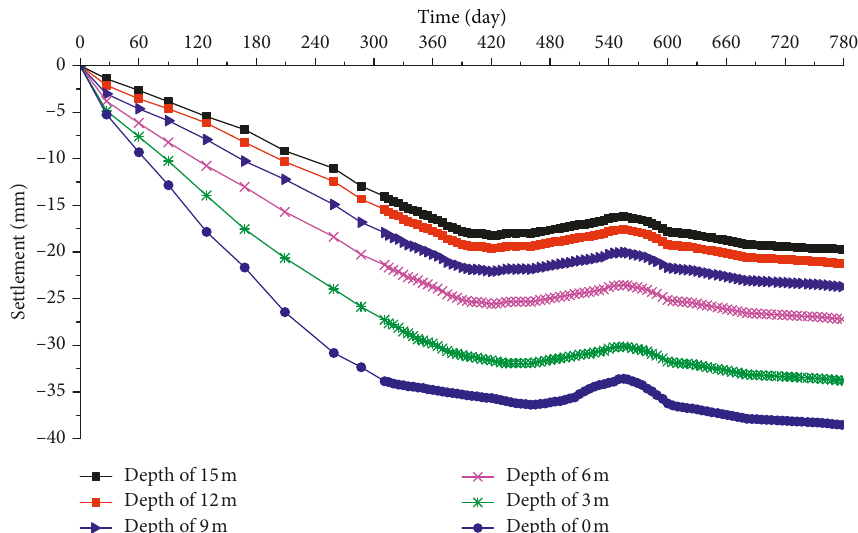
Figure 6: Variation of the settlement with time for different depths of